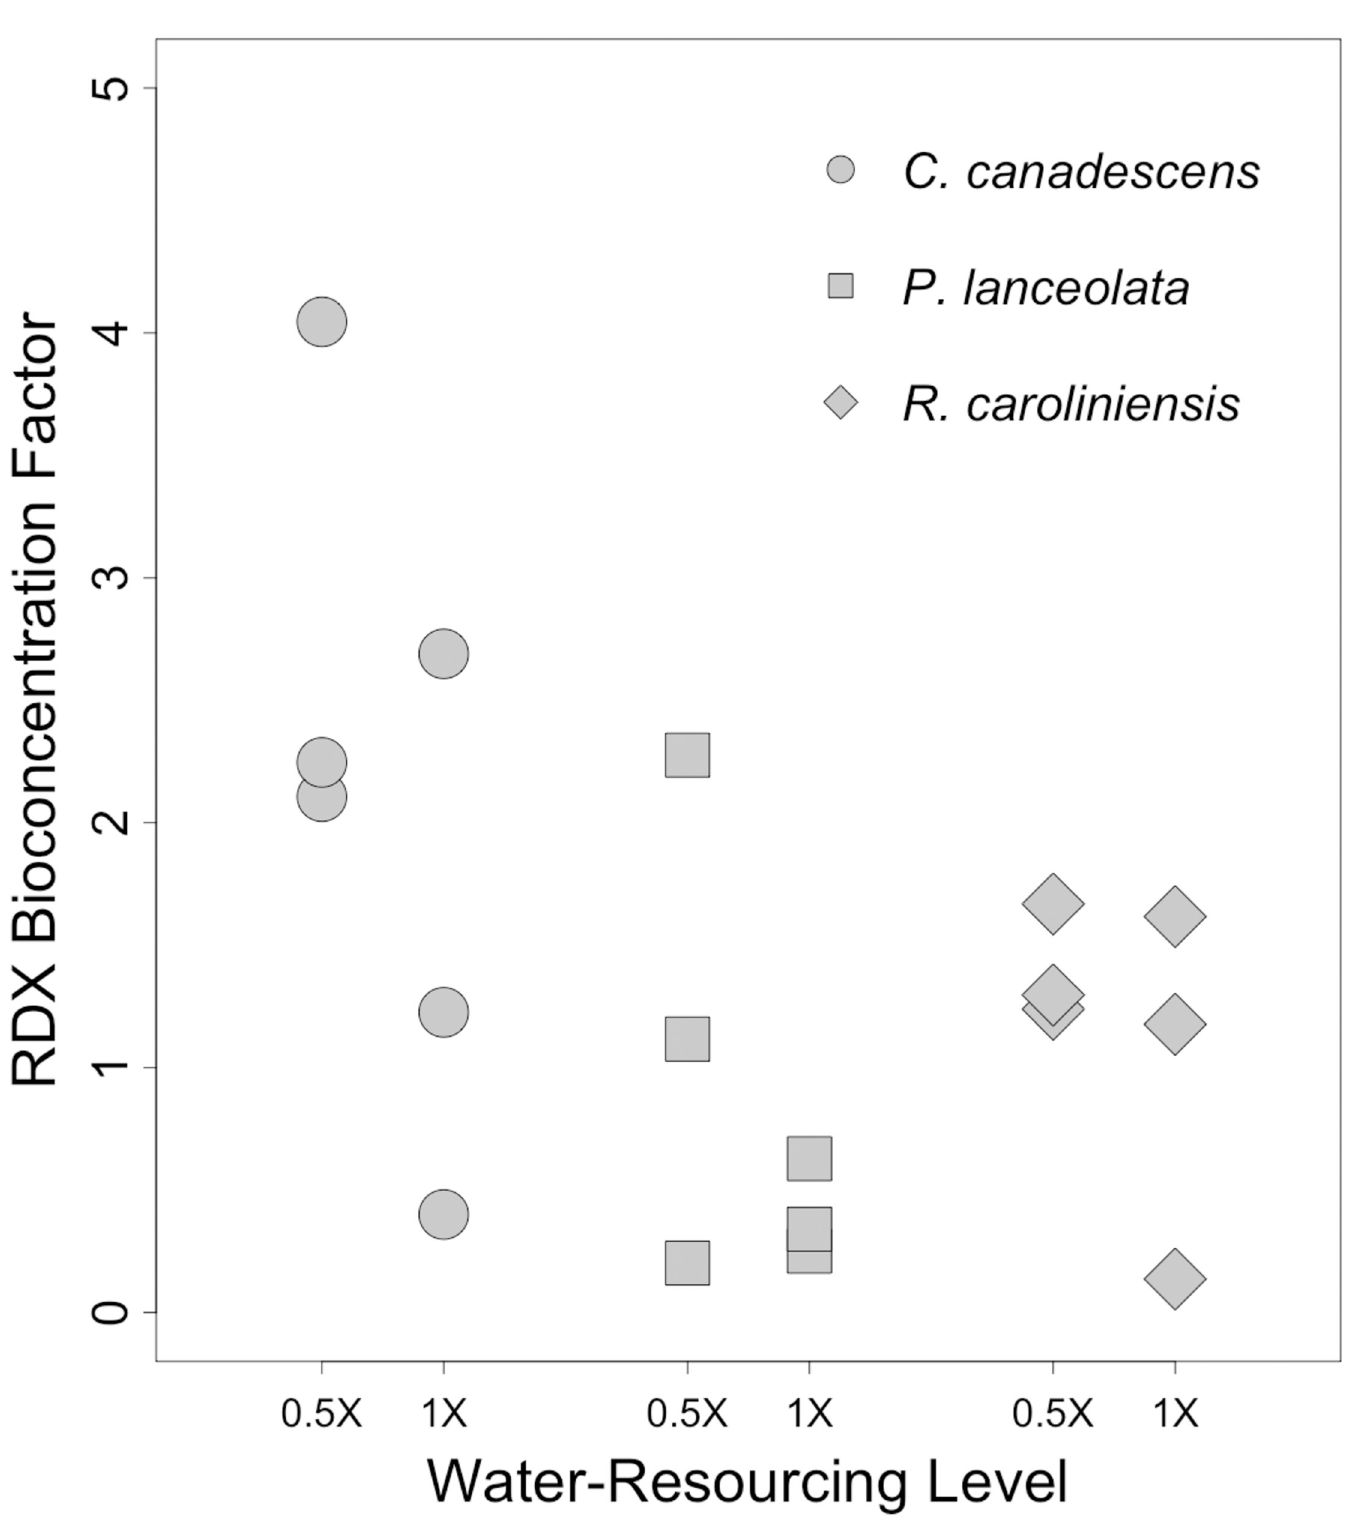
Fig 8. RDX bioconcentration factors in outdoor trials. Bioconcentration factors ( BCF s) for RDX in leaf and shoot tissues of three different plant species maintained outdoors with either a 1X or 0.5X water-resourcing treatment for at least 41 days. Initial concentration of RDX in potting soils was 100 ppm. For each species, above- ground tissues from n = 3 plants were sampled per treatment